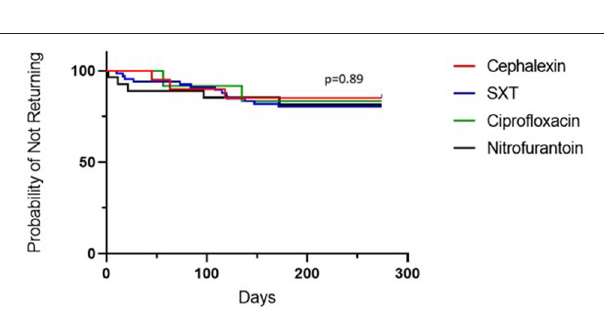
FIGURE 5 | Percentage of patients who did not return to the clinic for recurrent and/or persistent UTI symptoms in the 6 months following diagnosis, by antibiotic. Kaplan-Meier estimates for patients receiving each